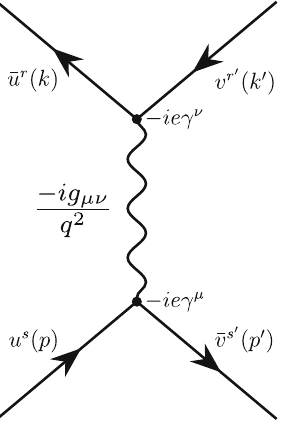
Fig. 1 An example diagram expressing the process e + e − → μ + μ − at the lowest order in the corresponding perturbative expan- sion [1]. The matrix element A for this diagram is: A = ¯ v s (cid:6) ( p (cid:6) )( − ie γ μ ) u s ( p ) − ig μν ¯ u r ( k )( − ie γ ν )v r (cid:6) ( k (cid:6) q 2